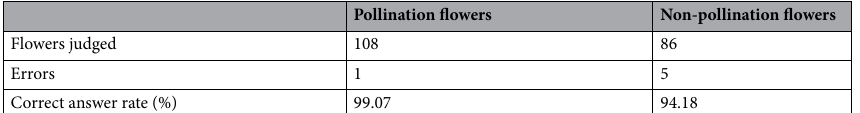
Pollination flowers